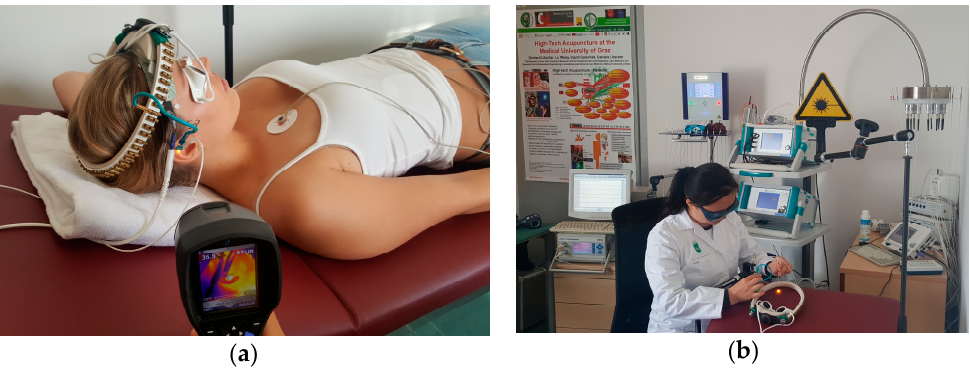
Figure 2. Yellow laser acupuncture at the ear point Shenmen ( a ) at the TCM Research Center of the Medical University of Graz ( b ).